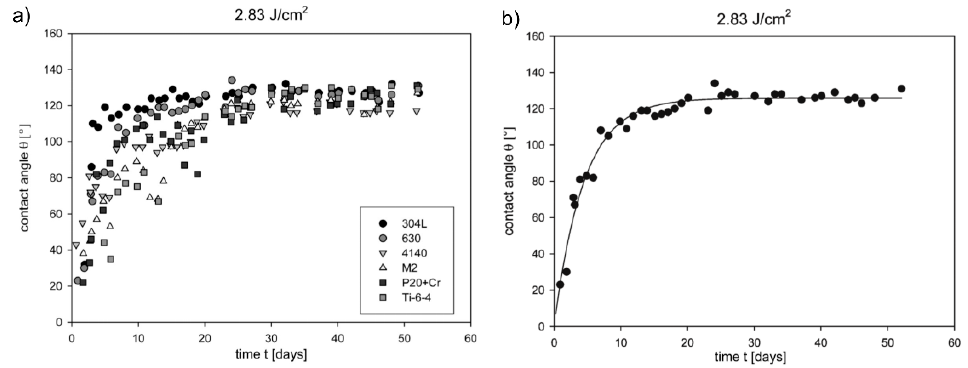
Figure 8. Evaluation of the time-dependency of θ of surfaces irradiated with F = 2.83 J/cm 2 : ( a ) θ of different substrate materials and ( b ) exponential growth regression on θ -evaluation in the case of stainless steel. Adapted with permission from Kietzig et al . [40], Copyright 2009 American Chemical Society.